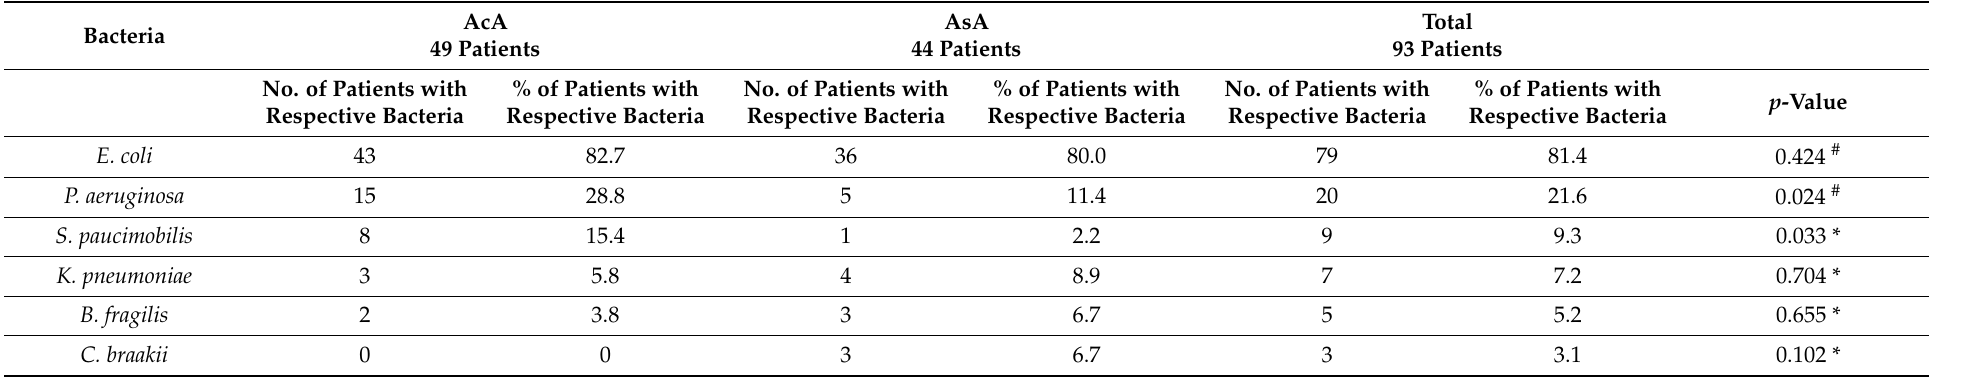
Table 2. Bacterial profile in acute complex appendicitis and acute simple